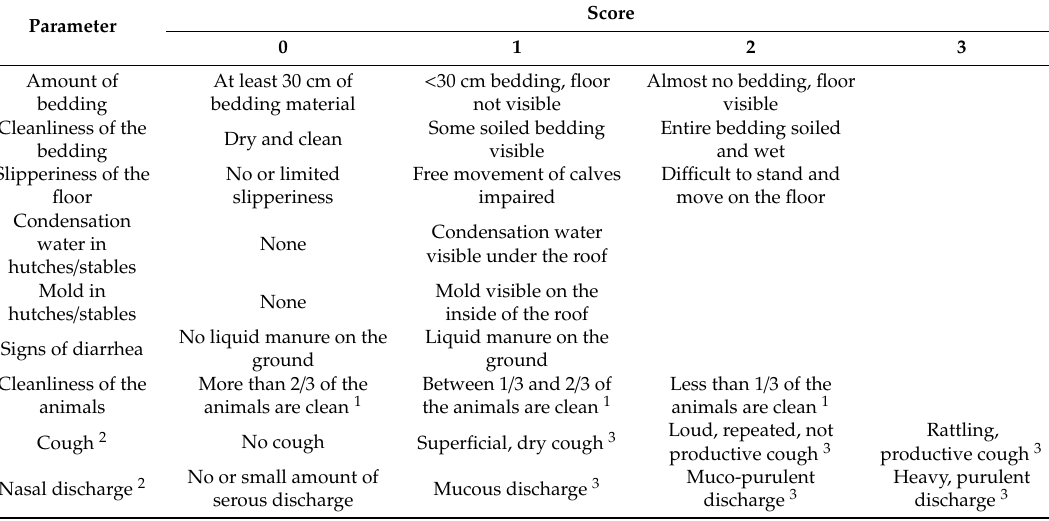
Table 2. Scoring system for indicators of calf welfare during monthly farm